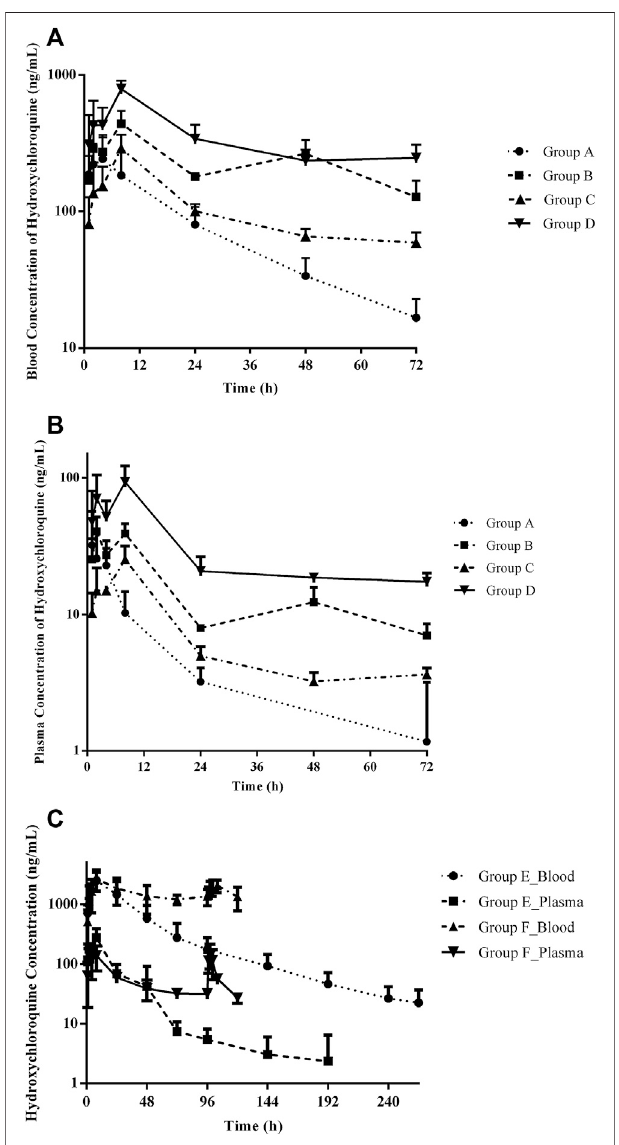
FIGURE1| SummaryofobservedHCQconcentrationsinthebloodand plasma after different treatment regimens. Group A: 6 mg/kg twice (day 1) following 2 mg/kg twice daily (days 2 – 3); group B: 2 mg/kg twice (day 1) following 1 mg/kg twice daily (day 2 – 3); group C: 3 mg/kg twice (day 1) following 3 mg/kg twice daily (day 2 – 3); group D: 3 mg/kg (day 1); group E: 21 mg/kg twice (day 1); group F: 21 mg/kg twice (day 1) following 7 mg/kg twice daily (day 2 – 5). (A) Blood HCQ concentrations in groups A – D, (B) plasmaHCQconcentrationsingroupsA – D,and (C) HCQconcentrationinthe blood and plasma, respectively, in groups E and